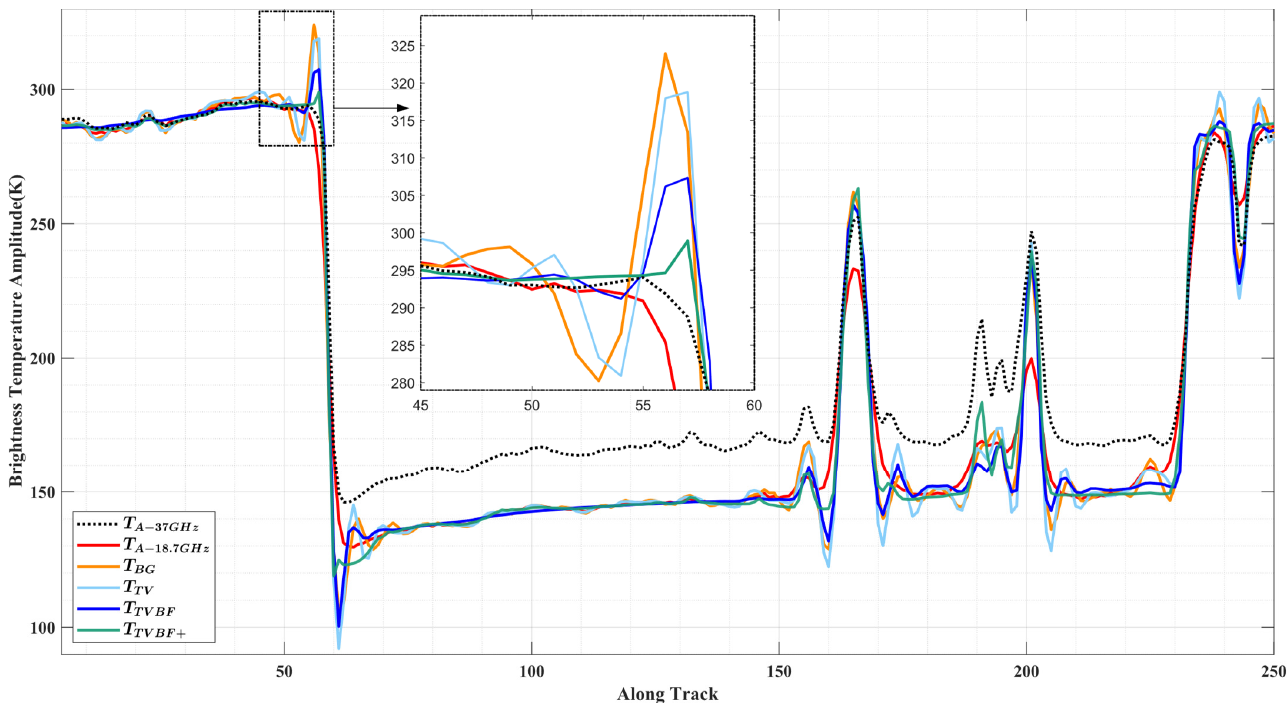
Figure 15. The along-track transects of the actual scenario (labeled with the dash-dotted line in Figure 14).